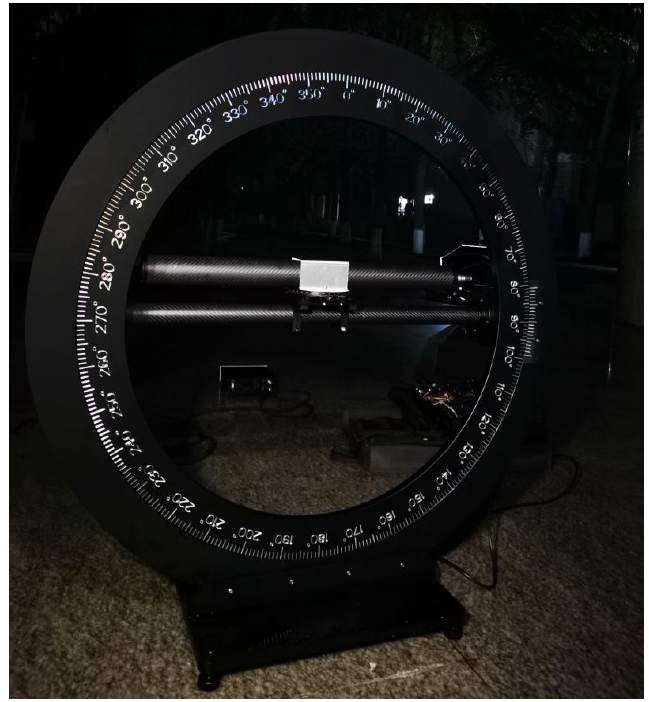
Figure 5. The optical pump magnetometer with high precision.